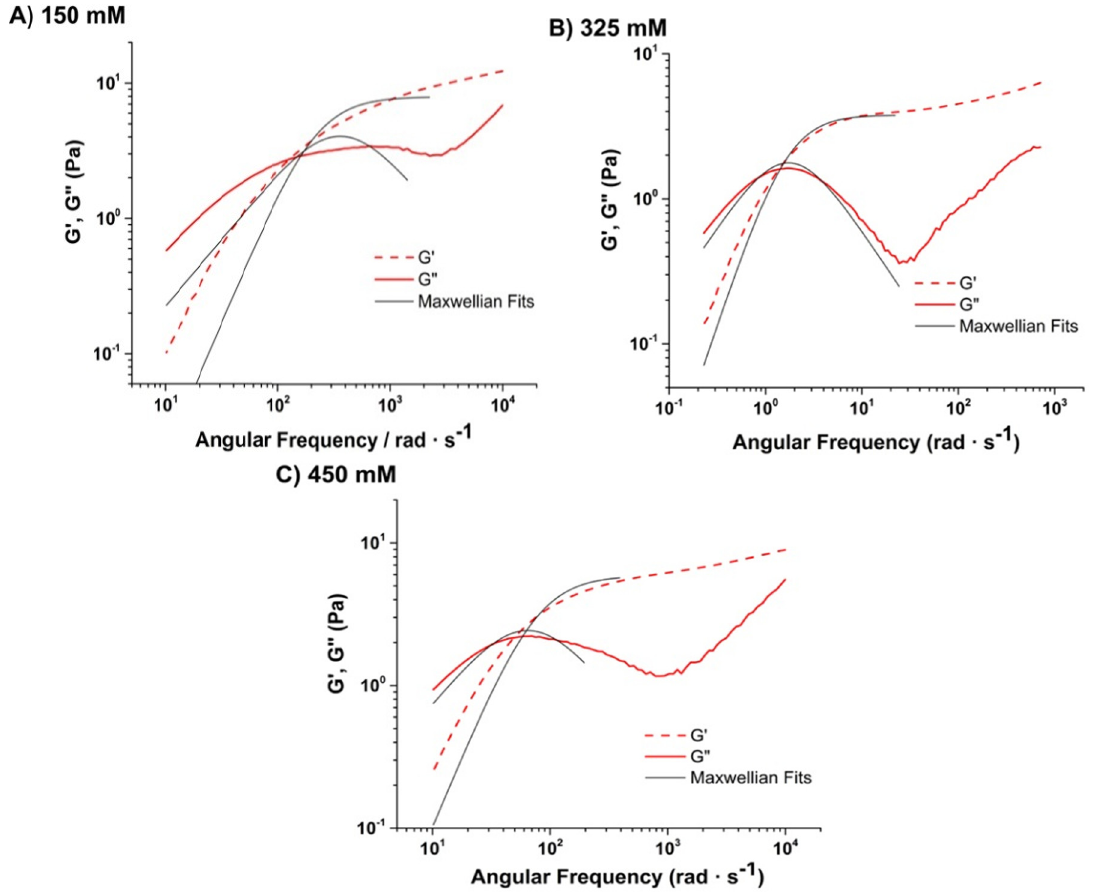
Figure 4. Evolution of frequency response of G ′ , G ″ of SLES/CapB with increasing NaCl concentration: ( A ) 150 mM; ( B ) 325 mM and ( C ) 450 mM. Solid black lines are fits to the Maxwell